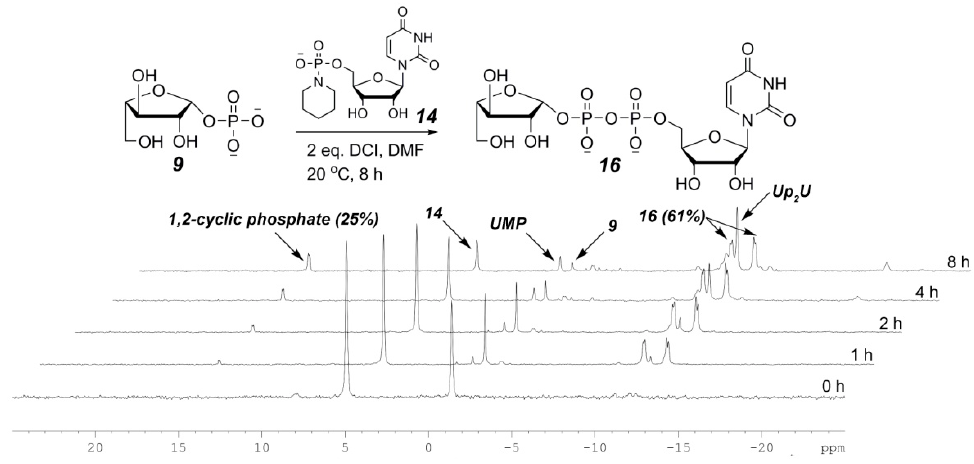
Figure 2. 31 P NMR tracing of the coupling reaction of 9 and 14 with 2 equiv of DCI.